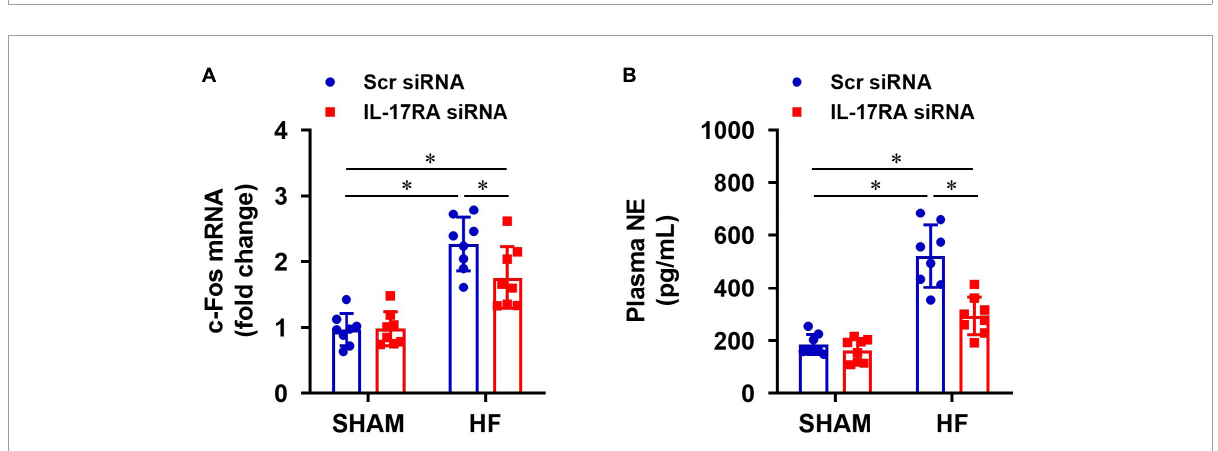
FIGURE5 Effect of bilateral PVN microinjection of IL-17RA siRNA on mRNA expression of c-Fos (a marker of neuronal activity, A ) in the PVN and on levels of plasma norepinephrine (NE, a marker of sympathetic nerve activity, B ) in SHAM and HF rats 4 weeks after CL. Values are mean ± SEM ( n = 8 for each group); * p <